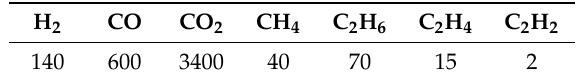
Table 2. The 95% typical concentration values (ppm) in bushings proposed in the Framework Instruction of Transformer Operation (Poland)